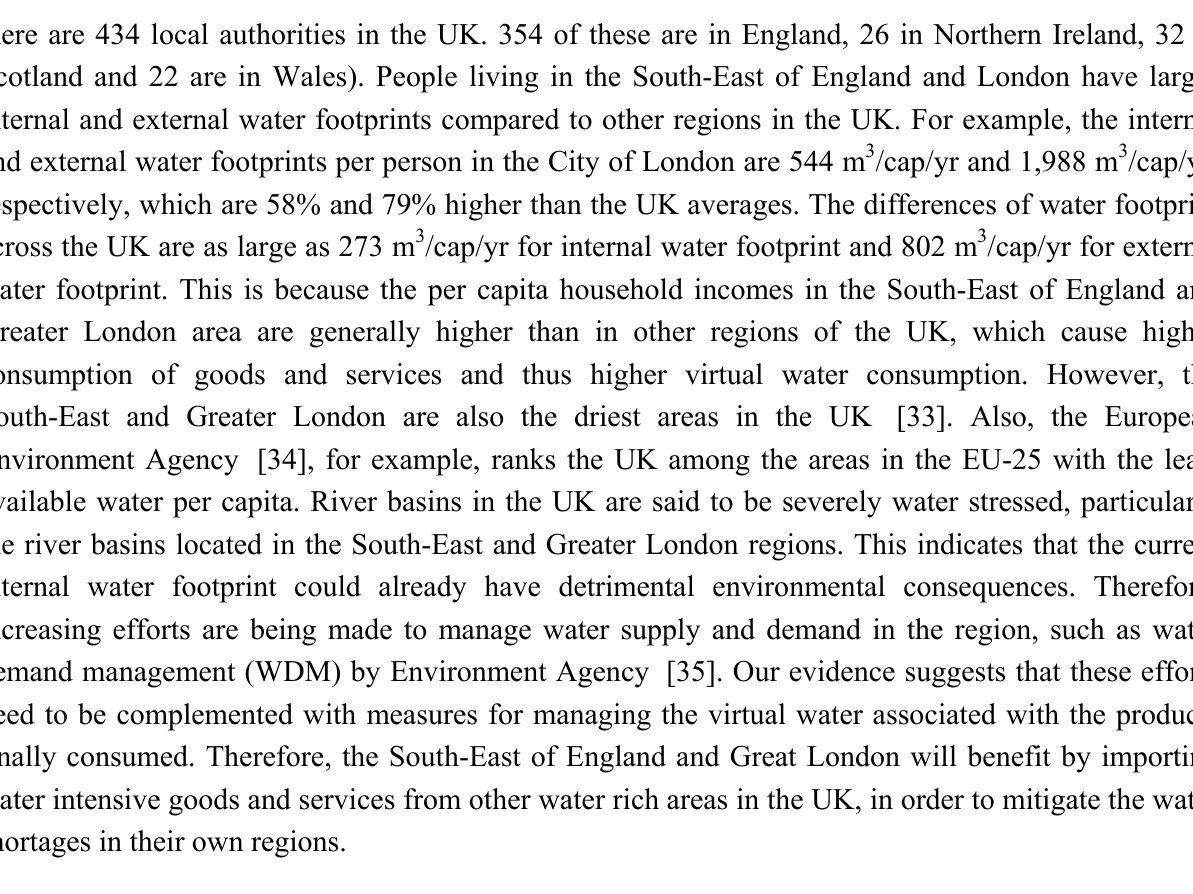
Figure 3. UK internal and external water footprints per person at the local authority level (m 3